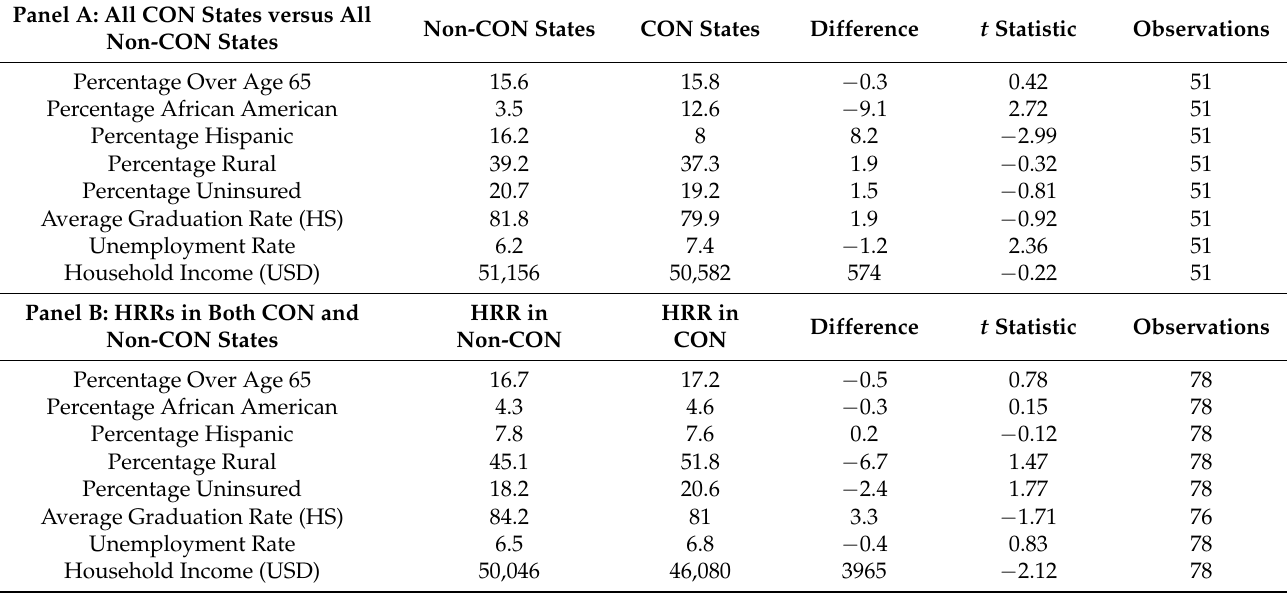
Table 4. Differences-in-means tests: covariates